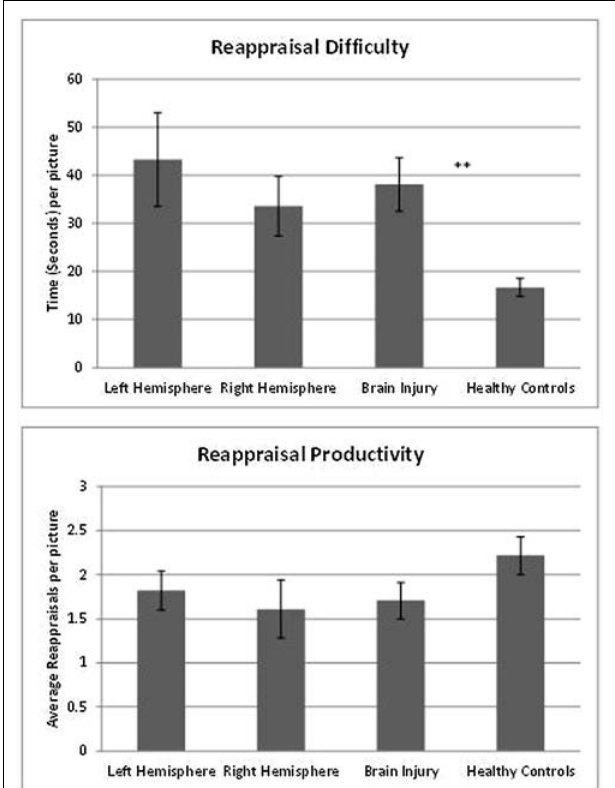
FIGURE 1 | Laterality and reappraisal generation. The figures describe differences between neurological groups and controls in reappraisal difficulty and productivity . Patients with left hemisphere and right hemisphere lesions are equally slow generating the first reappraisal (top figure). However, they do not differ from controls in the average number of reappraisal produced in each picture (bottom figure), ** p < 0.001.